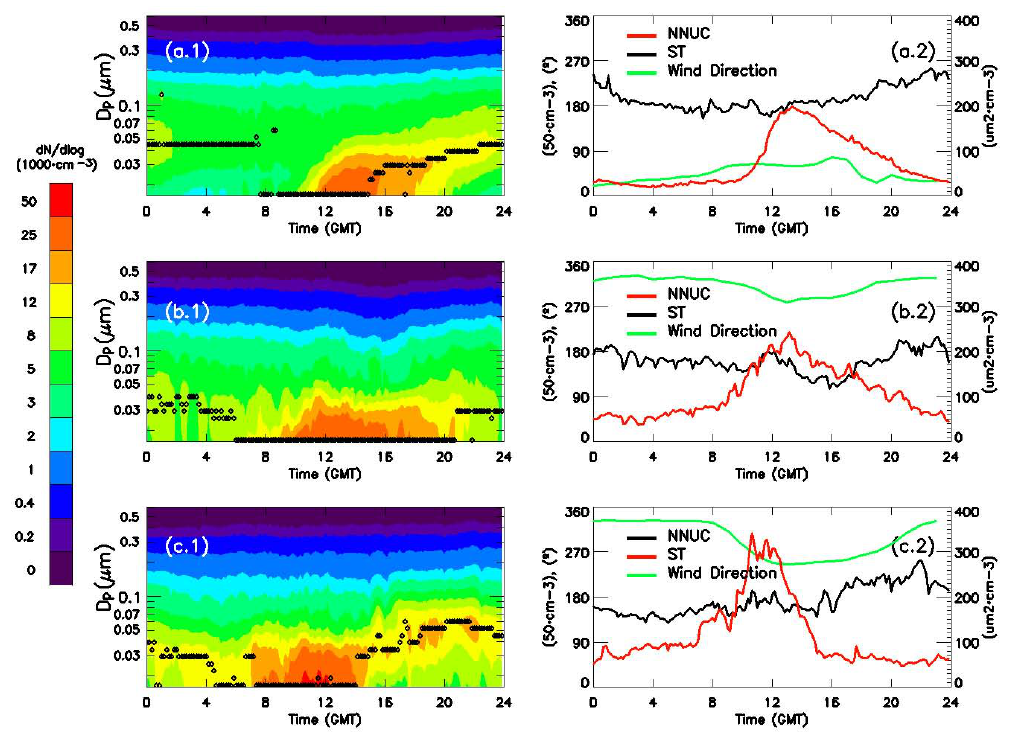
Fig. 12. Classification of the new particle formation events depending on wind direction during the hours prior to the nucleation burst particles and the regional or synoptic-scale pattern. ( a.1 and a.2 ) Event N 1 , if the wind was coming from the NE (48 days), ( b.1 and b.2 ) Event N NB if the wind was coming from the NW under synoptic-scale pattern (23 days) and ( c.1 and c.2 ) Event N B 2 from the NW under sea-land breeze pattern (19 days). Mean size distribution, N NUC , S T and wind direction are also shown for Events N 1 , N NB and N B 2 2